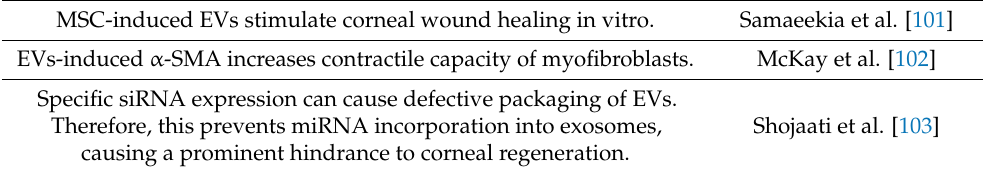
Table 1. EVs roles in corneal regeneration in mice. MSC-induced EVs stimulate corneal wound healing in vitro. EVs-induced α -SMA increases contractile capacity of